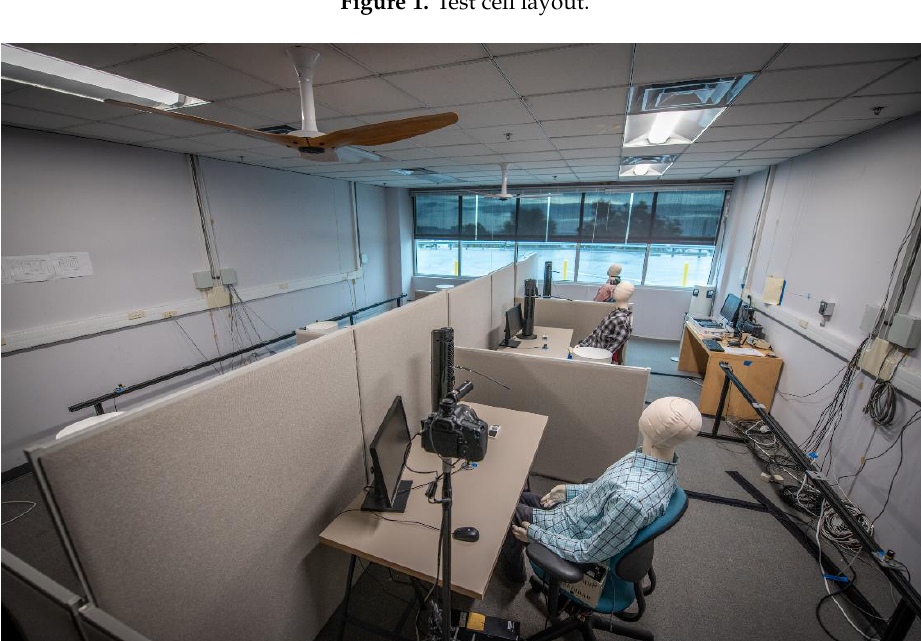
Figure 2. Interior view of test cell setup. Visible in the photograph are the LED fixtures with integrated sensors and controls, automated shades deployed across the windows, occupant thermal generators (mannequins with electric resistance heat tape), the occupancy trigger mechanisms (oscillating tower fan cylinders with heating elements to emulate occupant motion) for pyroelectric infrared (PIR)-based lighting controls and plug load control, automated ceiling fans, and measurement equipment, including high dynamic range (HDR) cameras for glare analysis and illuminance sensors on the desks and